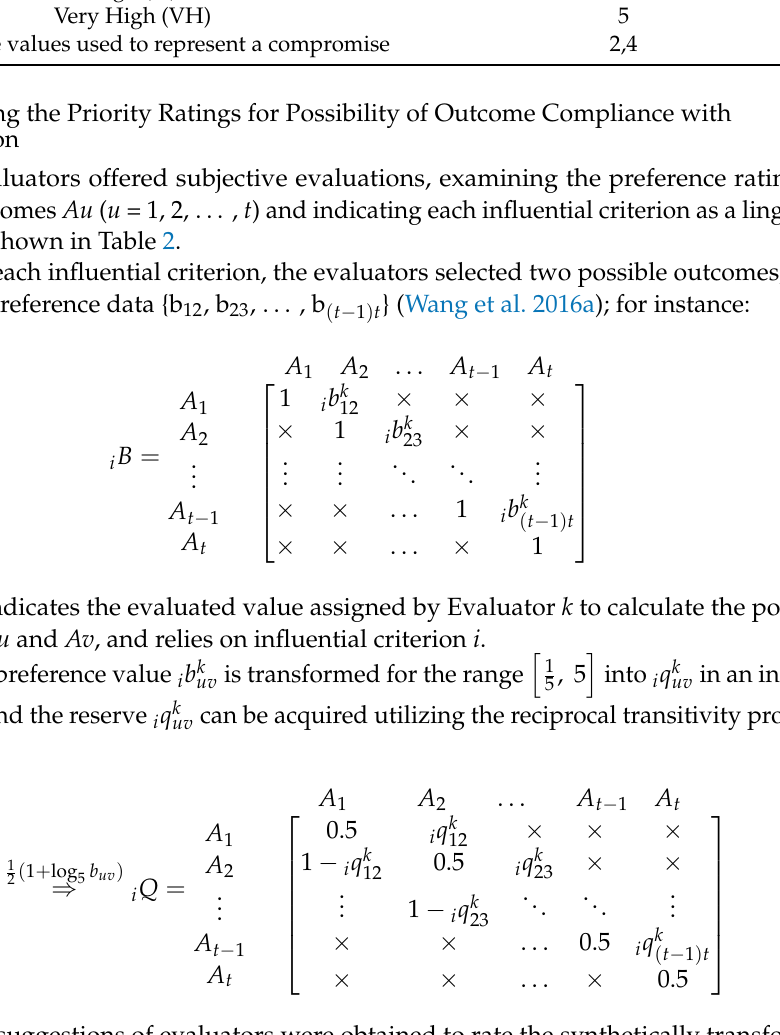
Table 3. Linguistic variables for the priority rating of possible outcome. Definition Intensity of Importance Fair (F) 1 High (H) 3 Very High (VH) 5 Intermediate values used to represent a compromise